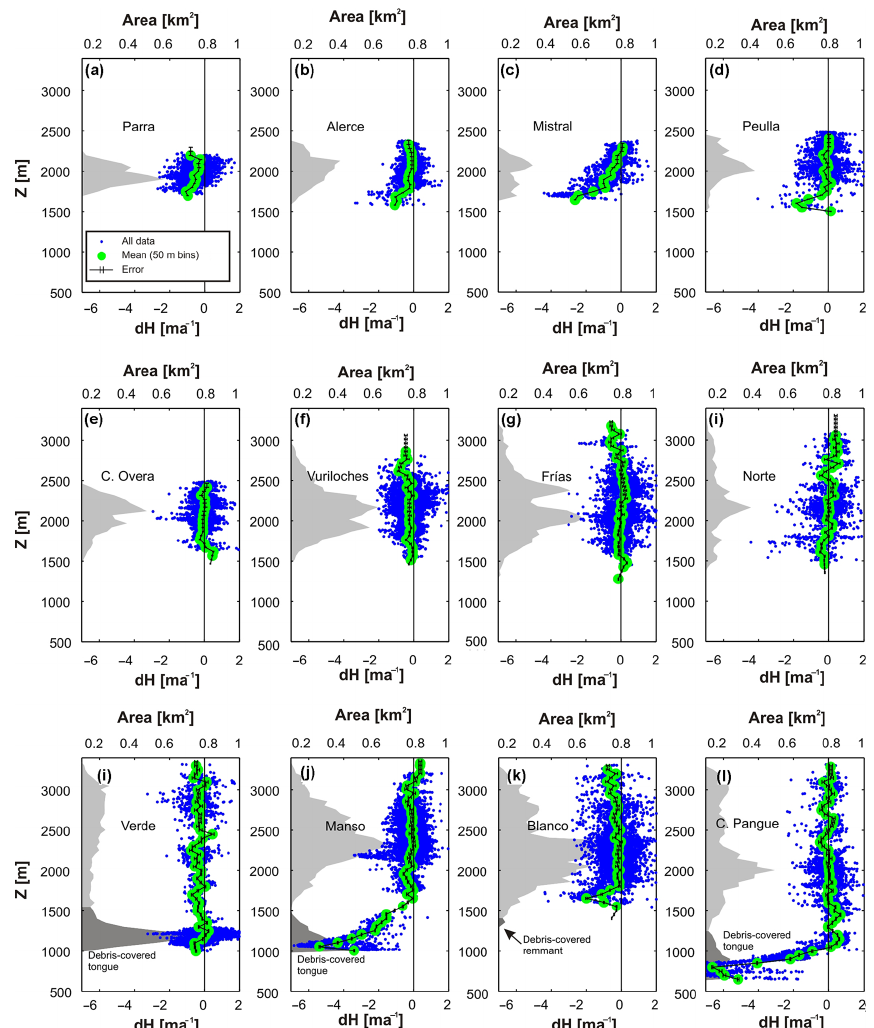
Figure 3. Elevation changes and hypsometry of Monte Tronador glaciers. Grey area shows the hypsometry of each glacier. The blue dots show all the elevation changes data for each glacier available after the curvature correction. The green dots represent the mean elevation change for each elevation band. The error bars (in black) are smaller than the green dots. For clear comparison all plots have the same scale and are sorted in glacier size in descending order. Glacier names are shown in each